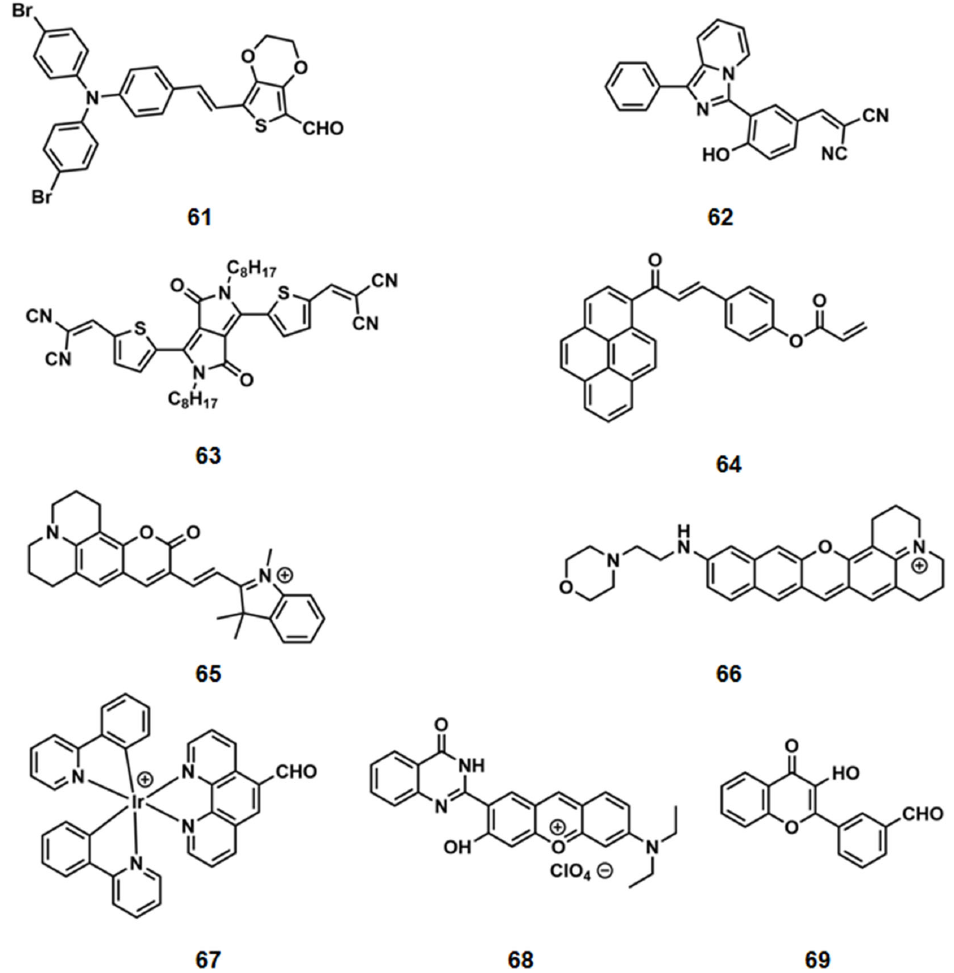
Scheme 11. Typical structure diagram of sulfite fluorescent probes 61 − 69